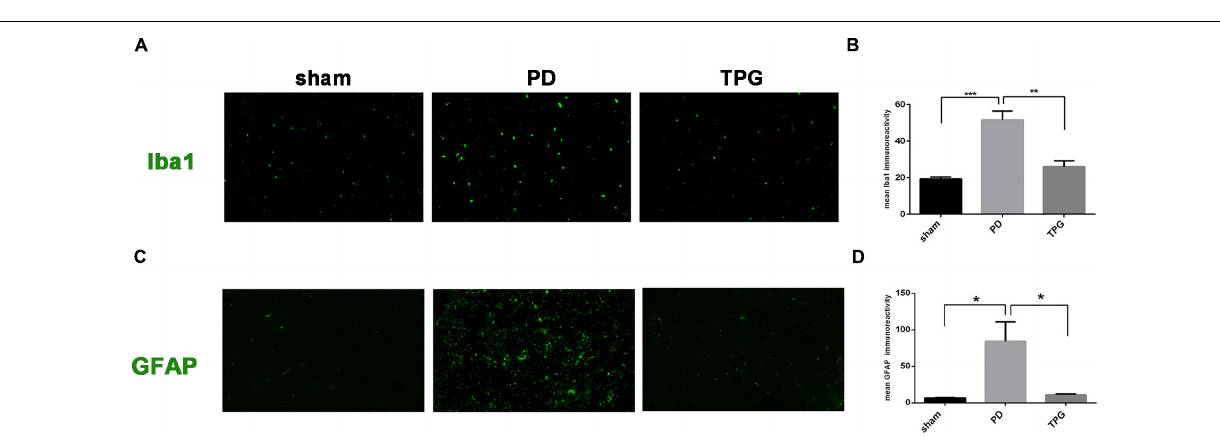
FIGURE 9 | Tianqi Pingchan Granule suppresses neuroinflammation in the lesioned substantia nigra. (A,B) Microglia activation was determined by immunohistochemical analysis of Iba1. (A) Typical photomicrographs show Iba1 (green)-stained astrocytes in the lesioned substantia nigra. (B) Quantitative analysis reveals a significant decrease in the Iba1 staining intensity in TPG rats. * p < 0.05, ** p < 0.05 vs. PD group. (C,D) Astrocytes activation was determined by immunohistochemical analysis of GFAP. (C) Typical photomicrographs show GFAP (green)-stained astrocytes in the lesioned substantia nigra. (D) Quantitative analysis reveals a significant decrease in the GFAP staining intensity in TPG rats. * p <